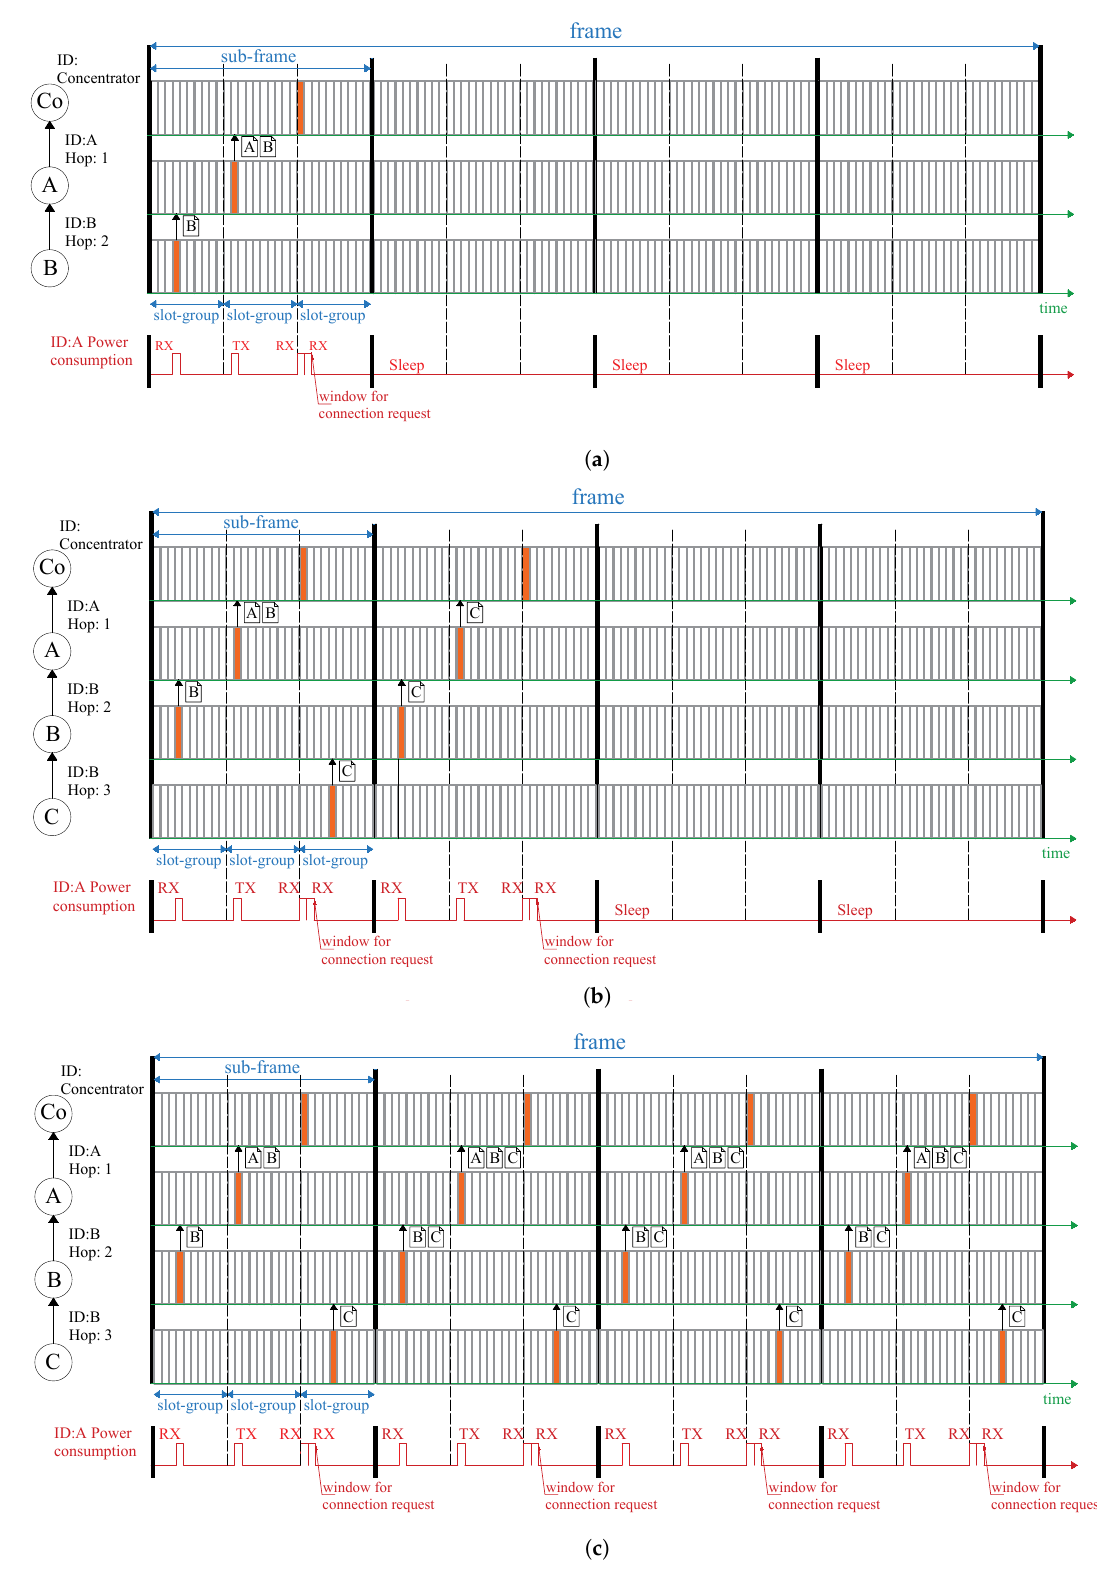
Figure 2. Frame configuration of LPMN: ( a ) when the maximum hop number is less than the slot- group number in a sub-frame ; ( b ) when the maximum hop number is the slot-group number in a sub-frame or above; ( c ) when the wireless node has a large amount of sensor